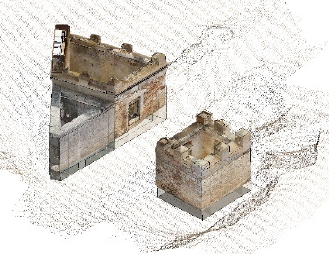
( c ) Figure 26. Different information that can be consulted in the model: ( a ) Material characterization; ( b ) archaeological information; ( c ) pathological information.